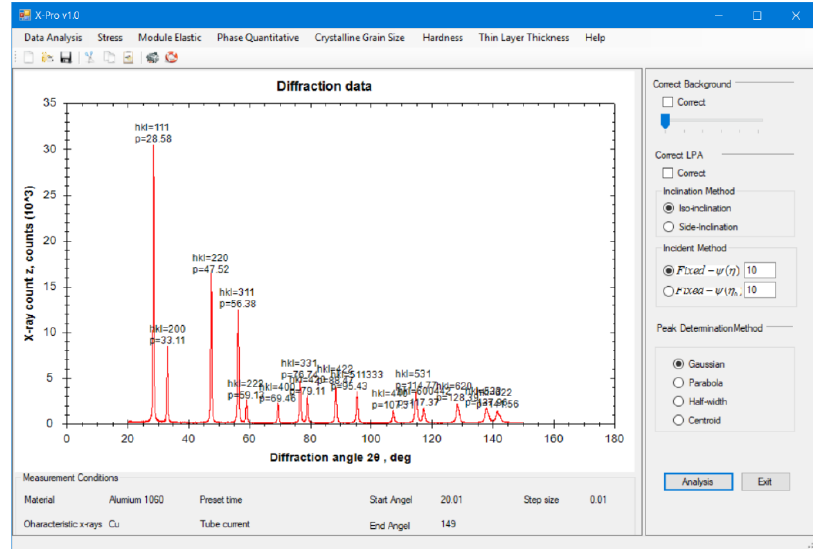
Figure 3. Main window for data analysis.